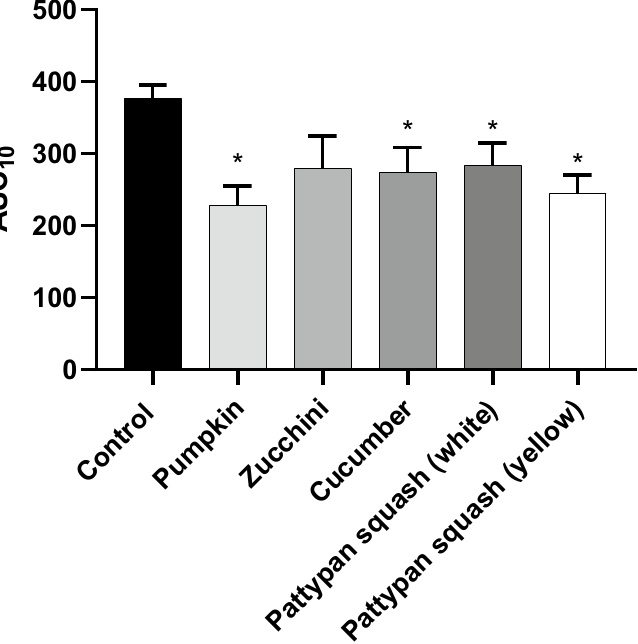
Figure 7. Effects of the five cucurbit vegetable preparations (concentration—50 µg/mL, incubation time— 30 min) on the T-TAS using the PL-chip in whole blood samples. Whole blood samples were analyzed by the T-TAS at the shear rates of 1000 s −1 on the PL-chips. The area under the curve (AUC 10 ) in PL are shown as closed circles. Data represent the mean ± SD of eight healthy volunteers (each experiment performed in triplicate). *p < 0.05 (vs. control blood).